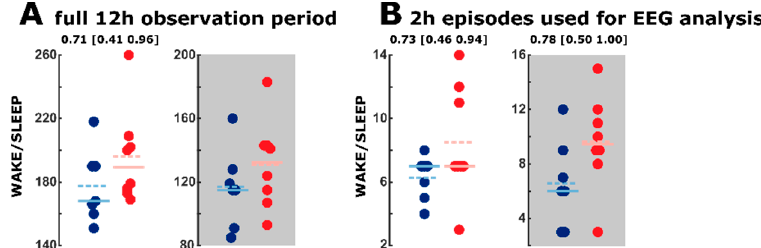
Figure 4. Dot plots inclusive mean (dashed line) and median (solid line) of transitions between WAKE and SLEEP of the AC group ( n = 7, blue) and the AD ( n = 8, red) group. ( A ) The plot represents the transition for the entire 12 h of the active or inactive period, scored in 10 s epochs. For the inactive period, we derived AUC values reflecting a fair effect. For the WAKE to SLEEP transition, AUC was 0.71 (95% CI: 0.41–0.96). ( B ) For the 2 h episodes (scored in 4 s epochs) used for quantitative EEG analysis, the AD animals showed a higher number of transitions as well.